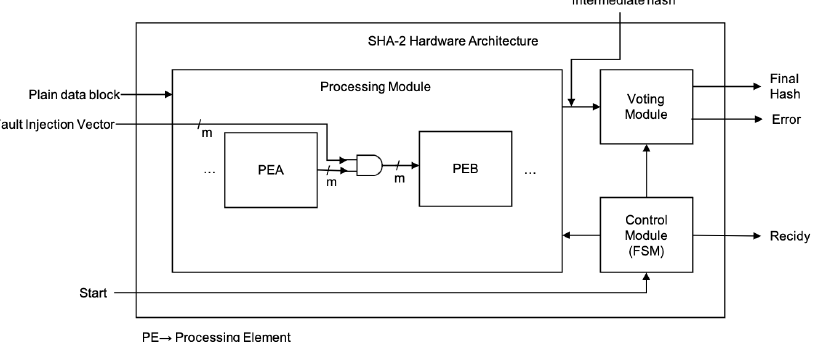
Figure 12. Modifications made to the hardware architecture in FPGA, only to evaluate, in a synthetic context, by injecting